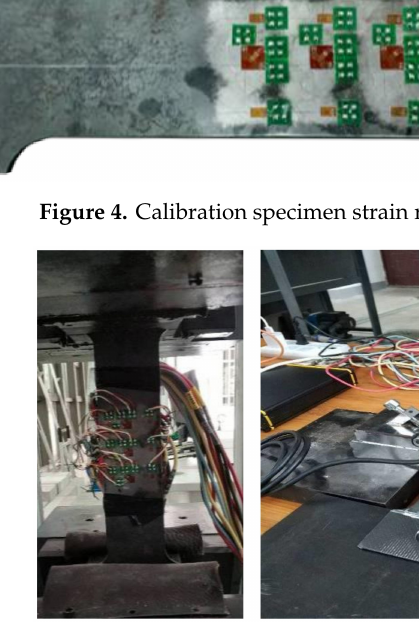
Figure 5. Calibration coe ffi cient